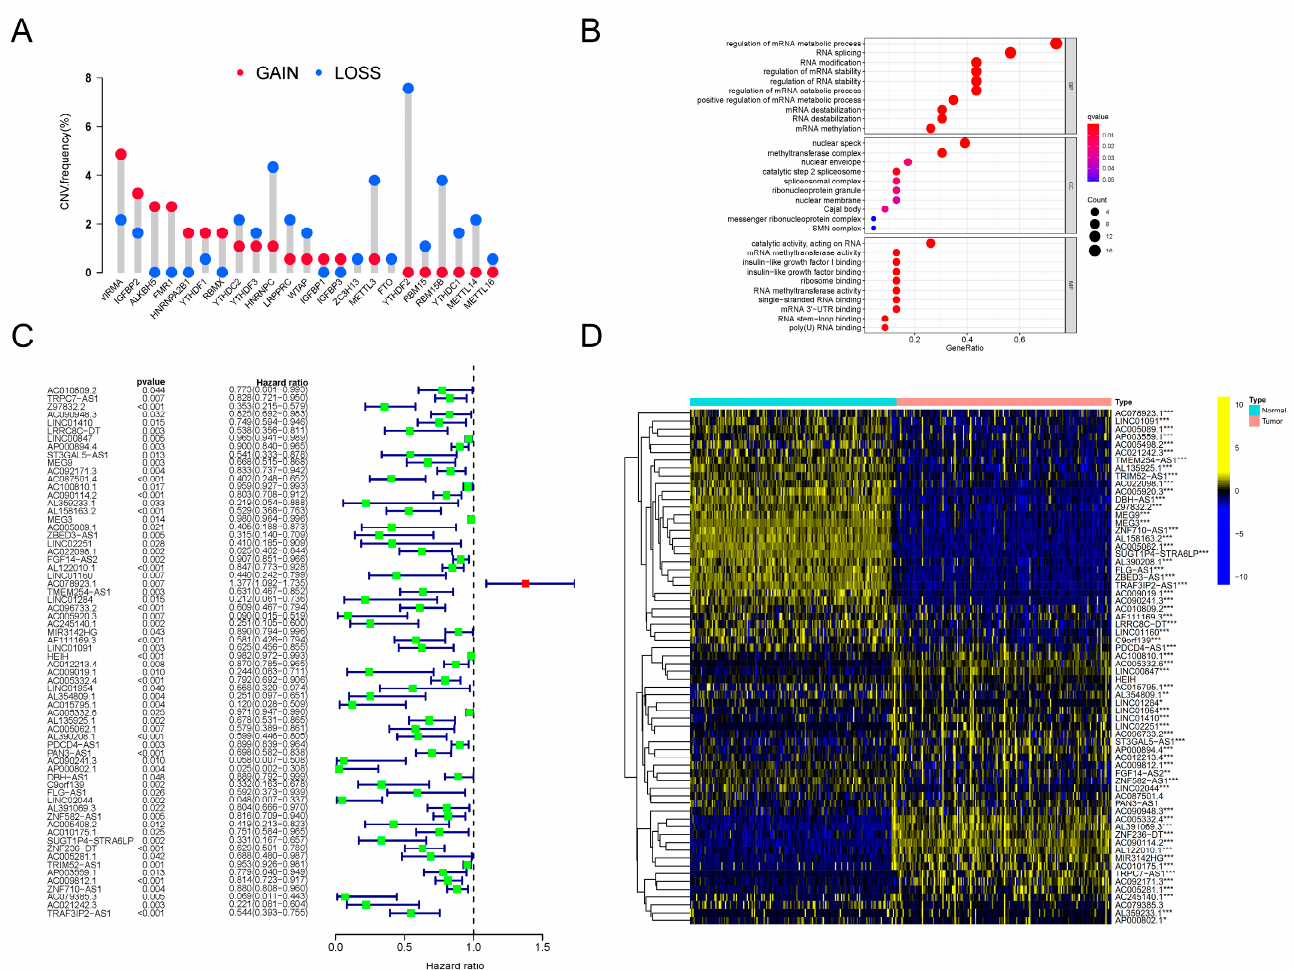
Figure 1. CNV analysis of m6A regulators and identification of prognosis-related m6A-lncRNA. ( A ) The frequency of CNV mutation analysis revealing the pervasive existence of genetic abnormality in all 23 m6A regulators in PDAC patients. The height of the column represents the mutation frequency. Red dots, amplification frequency; blue dots, deletion frequency. ( B ) Results of GO annotation analysis revealing the significantly correlated biological processes of 23 m6A regulators. The terms of biological processes are listed along the Y-axis, and the corresponding gene ratios are labeled on the X-axis. The bubble size stands for the number of enriched genes and the color depth stands for the degree of correlation significance. ( C ) The results of univariate Cox regression analyses were visualized in a forest plot ( D ). Heatmap presenting the differences in the expression level distributions of prognosis-related m6A-lncRNAs between normal samples (n = 171) and tumor samples (n = 177). * p < 0.05, ** p < 0.01, *** p <